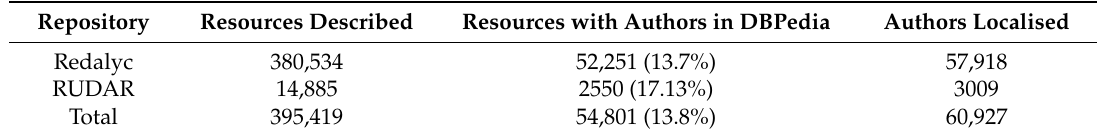
Table 3. Results of the process of author enrichment.